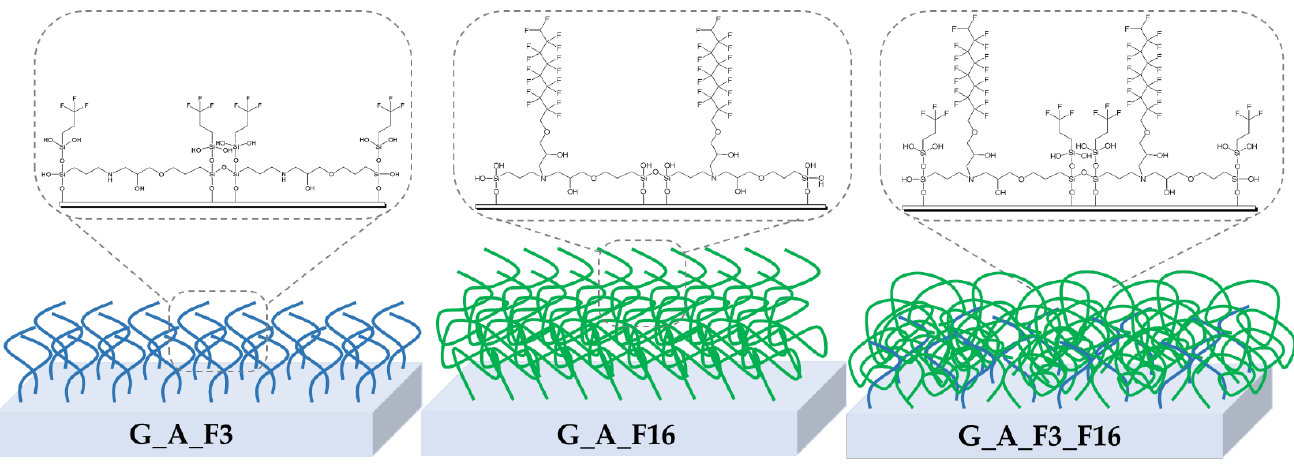
Figure 23. Sketches of F3 and F16 brushes distribution on fluorinated coated glasses.